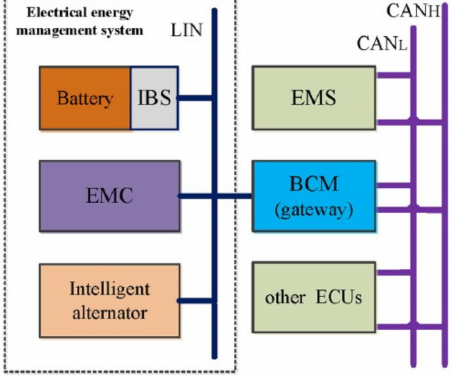
Figure 16. Transfer function block diagram of the proposed system